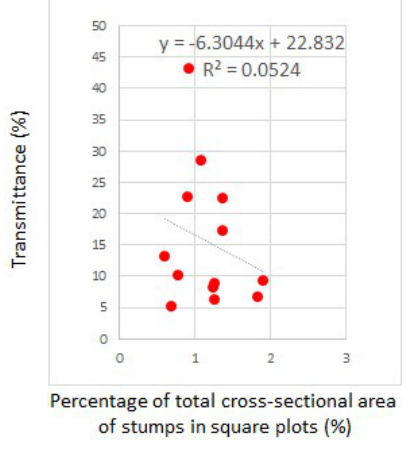
Figure 19 . Relationship between LiDAR transmittance and total cross-sectional area in granite site (Onigajo, Ojiroi and Yadaijin).